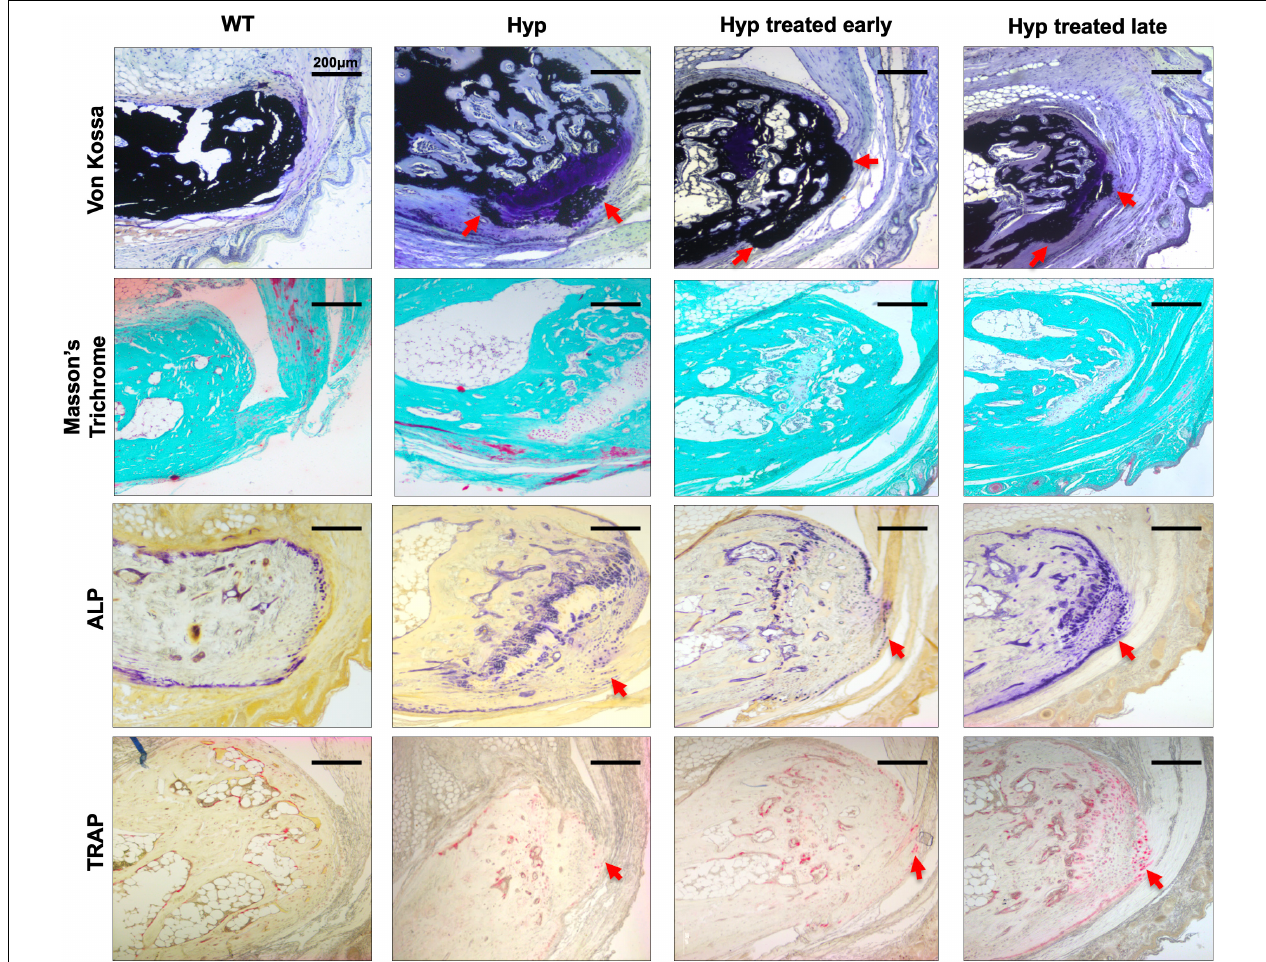
FIGURE 6 | Histological analysis of the calcaneus of 3-month-old WT mice, untreated Hyp mice, and Hyp mice on conventional treatment started early or late. Masson’s Trichrome and Von Kossa staining of undecalcified sections of calcaneal area confirmed the cellular expansion of mineralizing fibrochondrocytes into Achilles tendon and plantar fascia ligament insertions (red arrows) of the calcaneal tuberosity in Hyp mice. ALP and TRAP staining in the area of the enthesophytes at the insertion of the Achilles tendon and plantar fascia ligament was similar in Hyp mice that received treatment, either early or late, and in both cases (red arrows) more than that observed in WT mice. ALP, alkaline phosphatase; TRAP, tartrate-resistant alkaline